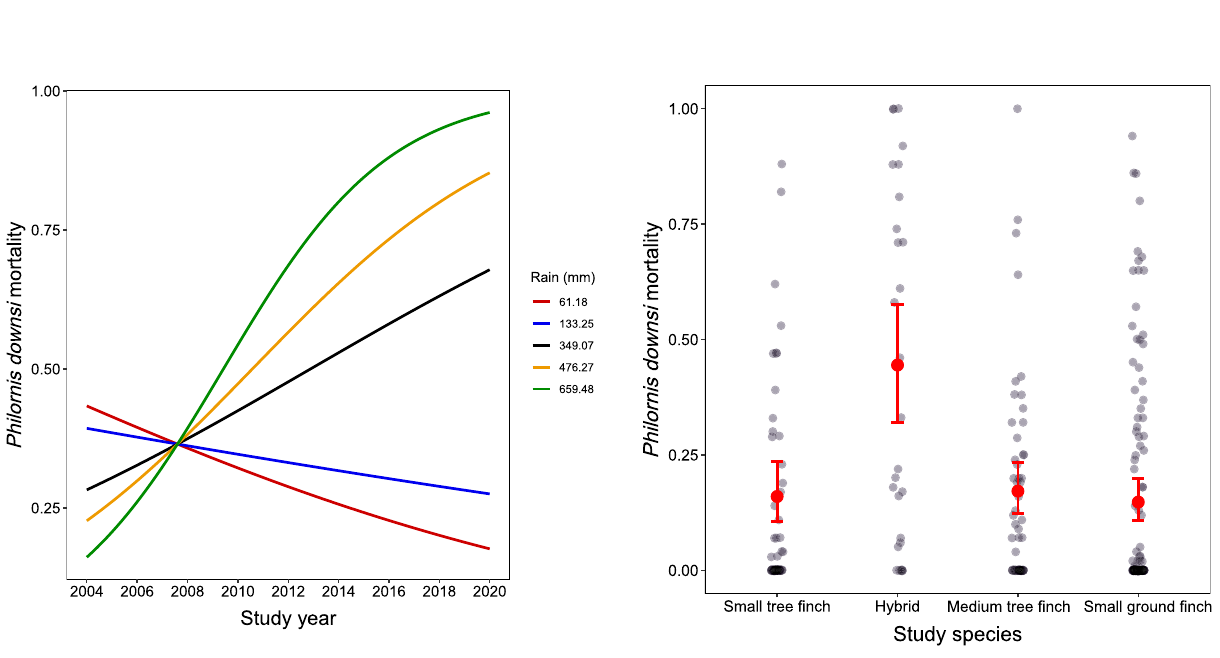
Figure 2. The relationship between avian vampire fly ( Philornis downsi ) in-nest larval mortality and ( a ) the interaction between study year and annual rainfall (sum in mm); and ( b ) the different Darwin’s finch species. Note the interaction is plotted for min (rainfall = 61.18 mm, red line), 1st quantile (rainfall = 133.25 mm), median (rainfall = 349.07 mm), 3rd quantile (rainfall = 476.27 mm) and max (rainfall = 659.48 mm, black dashed line) values; while the additive effect is plotted as effect sizes plus 95% CIs. Model details provided in Table